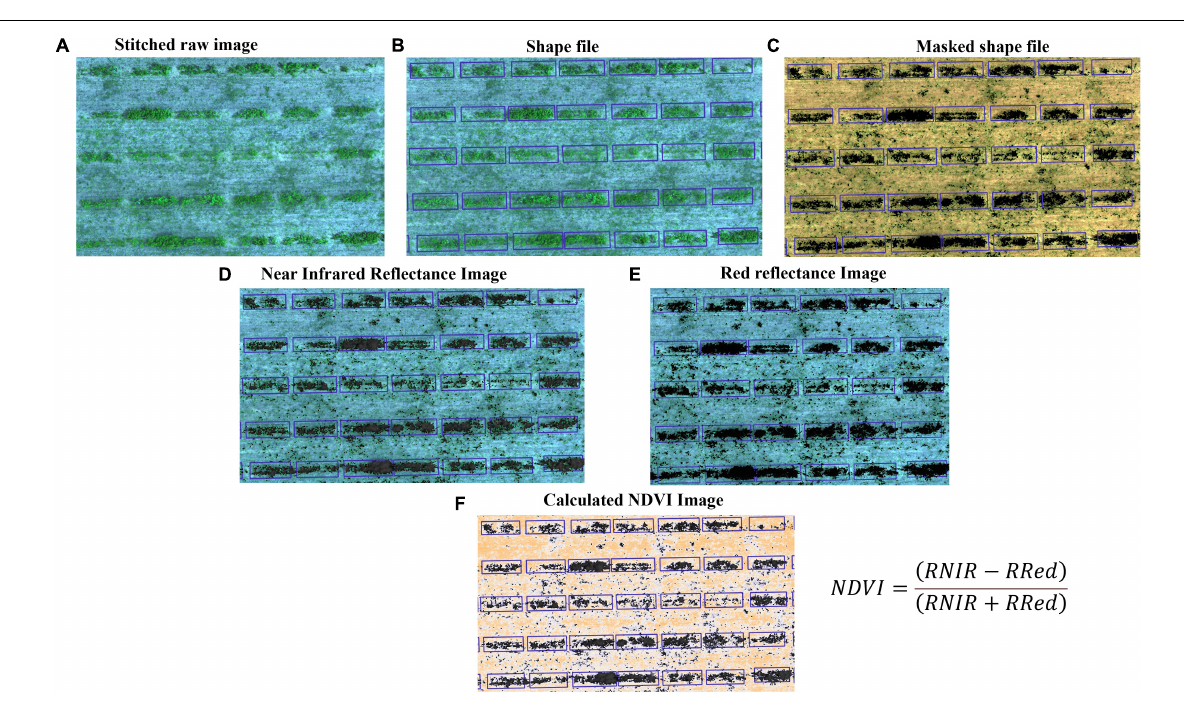
FIGURE 2 | Workflow of image processing and data acquisition for the HTP. (A) Stitched raw images (each row is visible) from multispectral camera, (B) Shape file: each plot is separated by grid line, (C) Masked shapefile: canopy and bare ground places are noticeable, and these images are used to generate vegetation indices, (D) Reflectance image of infrared band, (E) Reflectance image of red band, and (F) Calculated NDVI image using panels (D,E)